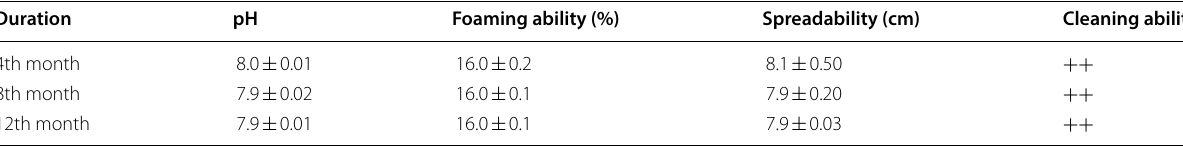
Table 5 Stability test for tooth paste formulation (F3) Duration